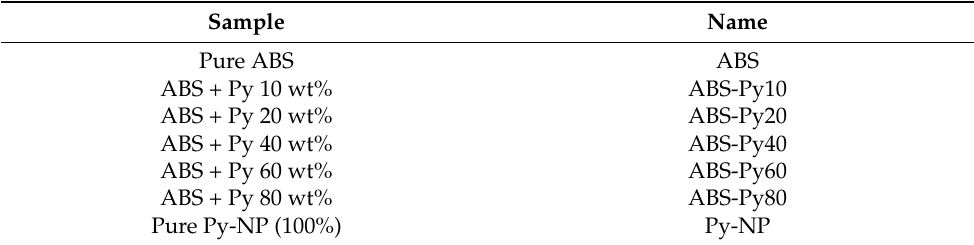
Table 1. Pristine as composite samples processed with varying Py content and the corresponding